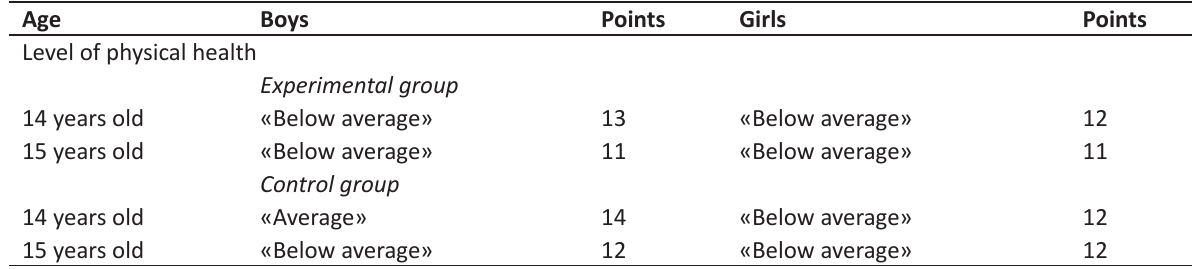
Table 1. Assessment of physical health of schoolchildren aged 14-15 years before the experiment Age Boys